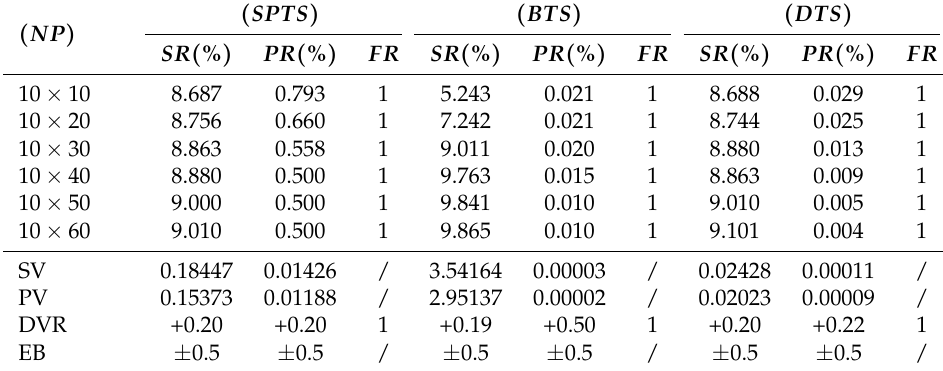
Table 2. Quantum simulation of high-dimensional data tables describing the three topological structures of the DE algorithm implied in β -Hilbert space about NP .